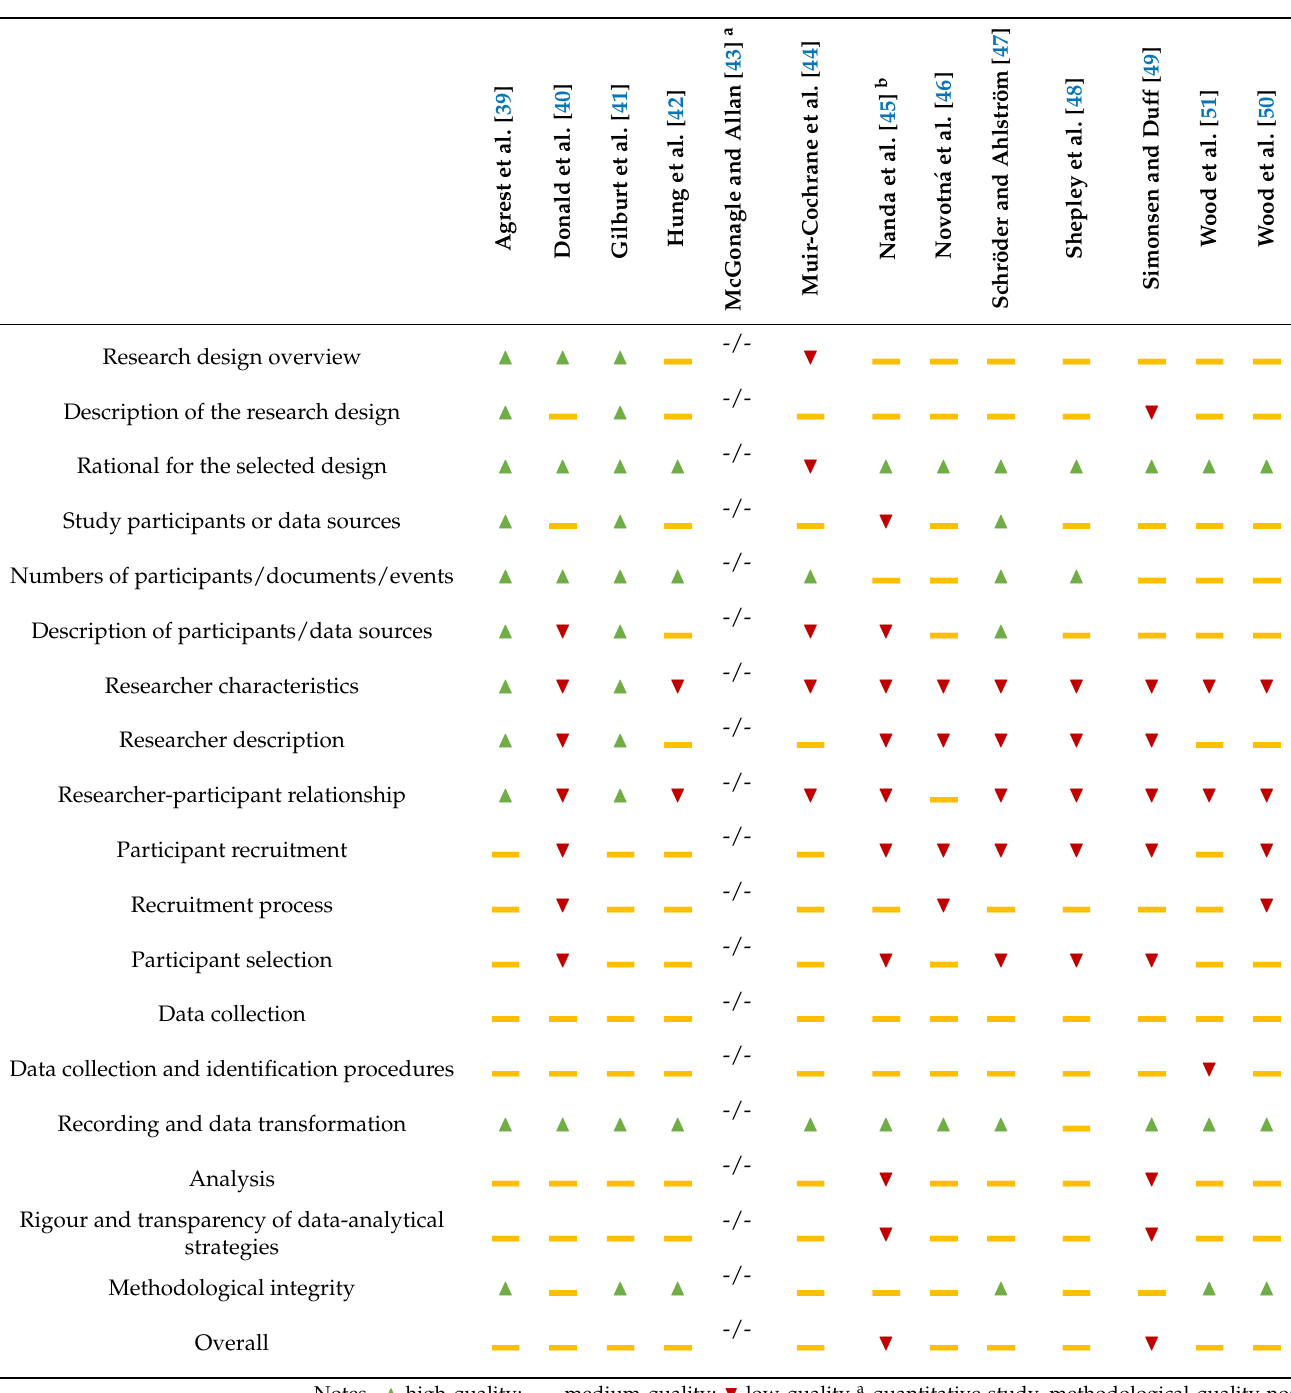
Table 5. Methodological quality of the included